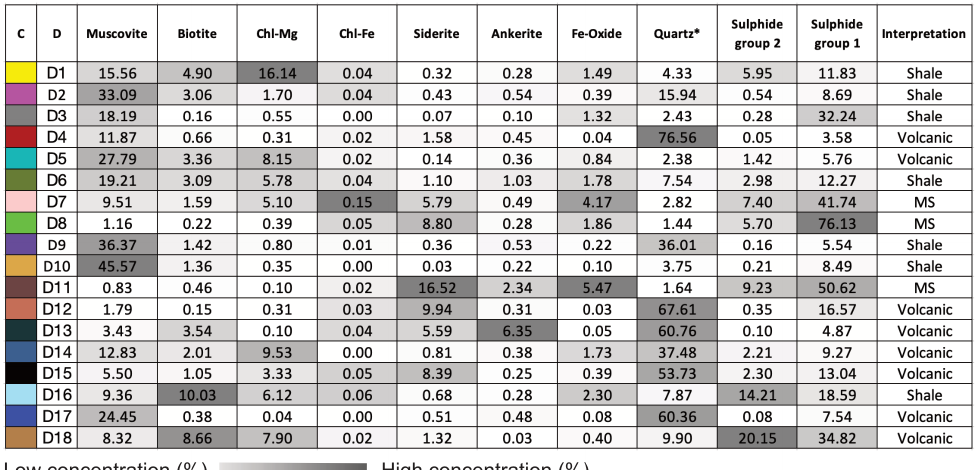
Figure A1. Unsupervised domain classification results, showing the domain color legend with average mineral abundances in percentage and the interpretation based on compositional data and knowledge integration. Massive sulfide